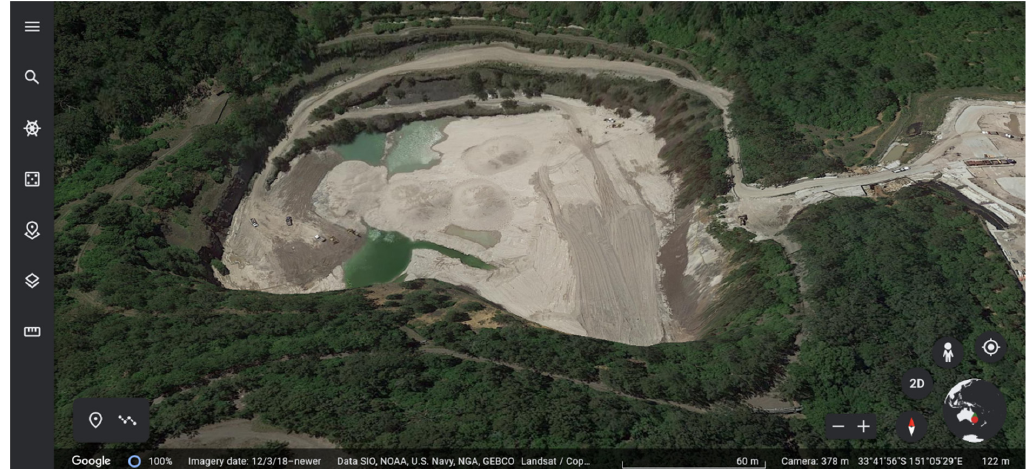
Figure 5. Current aerial view of the Hornsby Quarry, facing north (Google Earth image, dated 12 March 2018), showing partial infilling of the quarry by spoil. Scale bar shown is 60